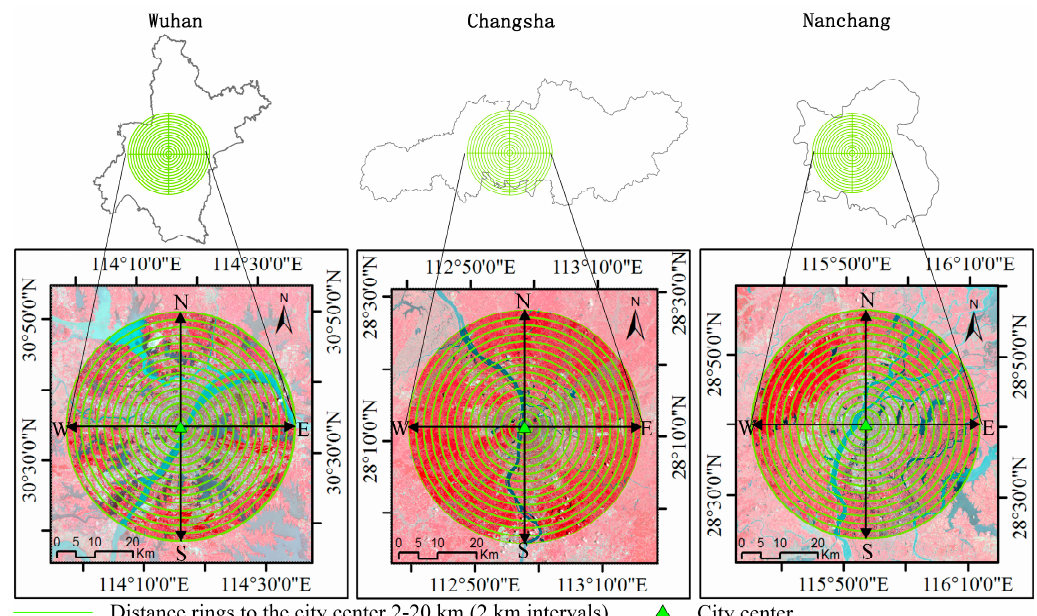
Figure 3. The spatial distribution of the buffer rings in each of the three capital cities.